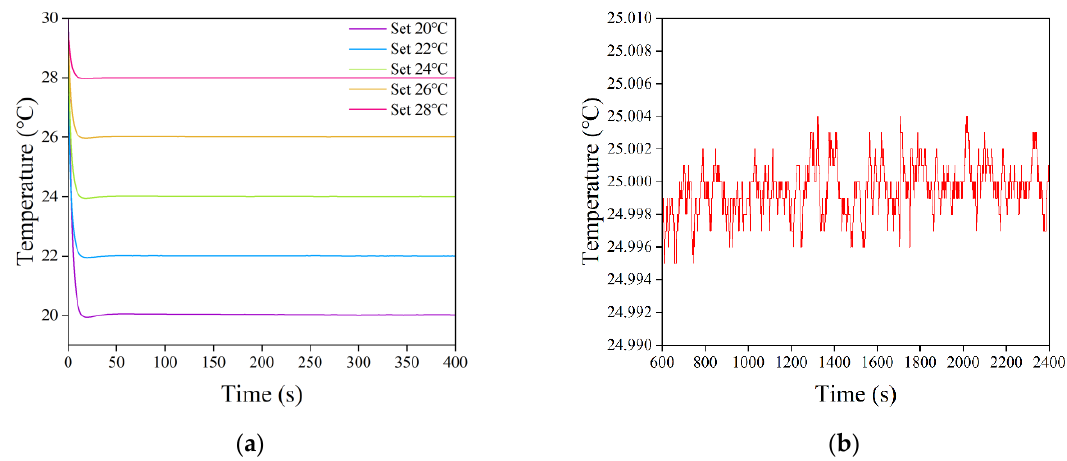
Figure 16. Temperature variation curve of a semiconductor laser: ( a ) temperature control stability experiment and ( b ) temperature control accuracy experiment.